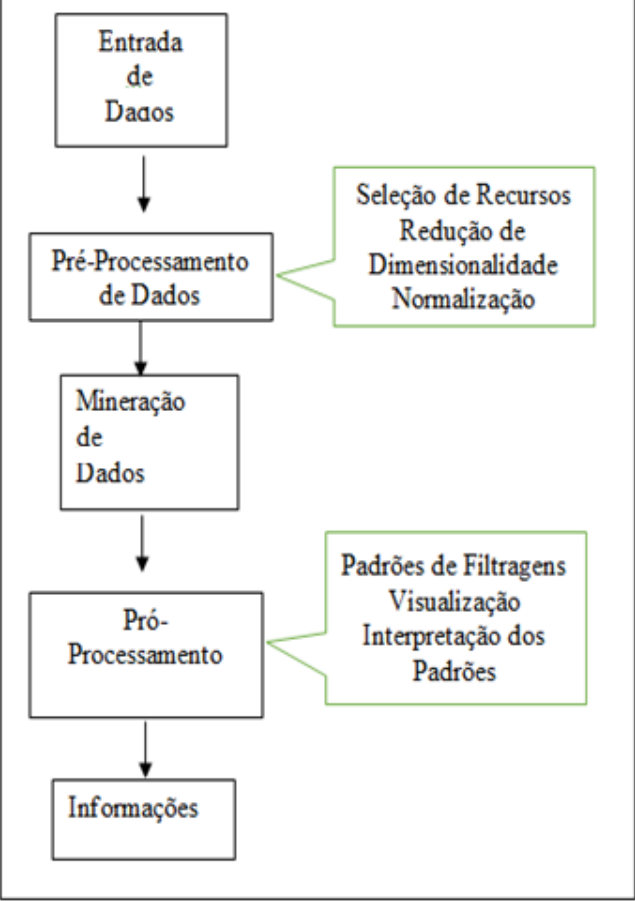
Figura. 1 Proceso de descubrimiento del conocimiento en bases de datos